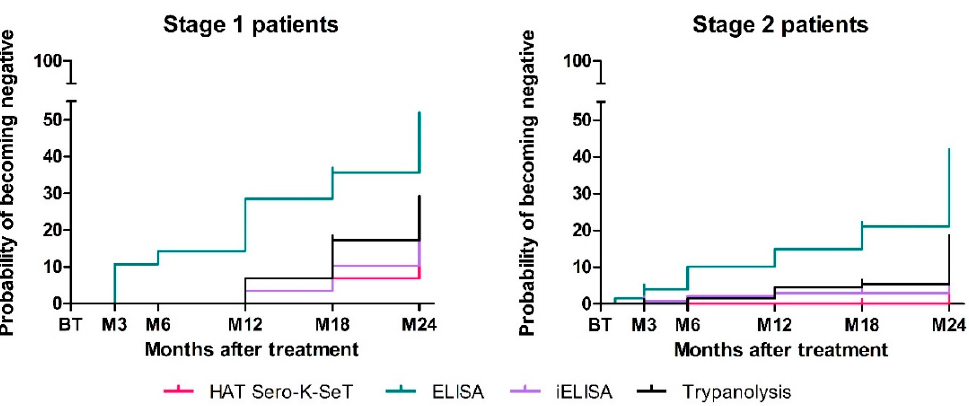
Figure 2. Kaplan–Meier curves displaying the sero-reversion probability of stage 1 and stage 2 patients by each serological test, expressed as percentages.